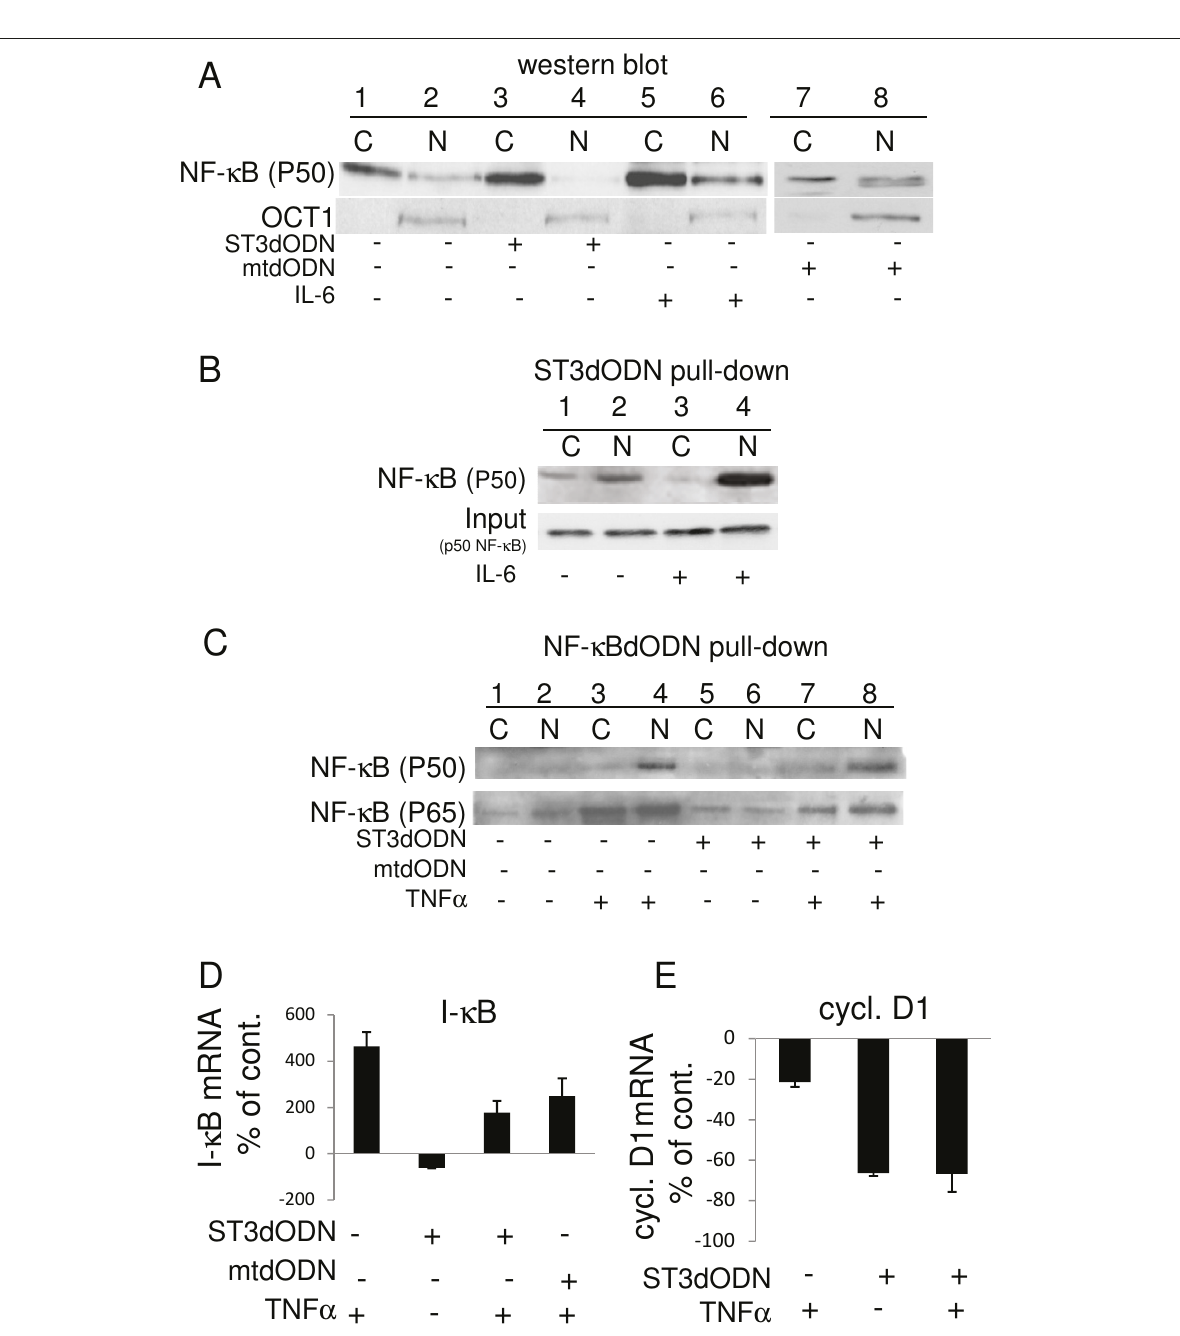
Figure 9 Functional interaction of STAT3 with NF- (cid:1) B in SW 480 cells . A : NF- (cid:1) B nuclear transfer in STAT3-decoy ODN-transfected SW 480 cells. Cells were transfected with STAT3-decoy ODN (ST3dODN) (2 μ g/ml) (3 and 4), IL-6 (50 ng/ml, 16 h) (5 and 6), or mutated STAT3-decoy ODN (mtODN) (7 and 8). Controls: 1 and 2. B : Probe of STAT3-decoy ODN pull-down with NF- (cid:1) B antibody in non-transfected cytoplasm and nuclear fractions (1 and 2) and in IL-6 (50 ng/ml)-treated cytoplasm and nuclear fractions (3 and 4). C : Analysis of NF- (cid:1) B activity by pull-down assay with NF- (cid:1) B-decoy ODN following treatment of cells with STAT3-decoy ODN (2 μ g/ml). Cells treated with TNF- a (20 ng/ml) (3 and 4) transfected with STAT3-decoy ODN (2 μ g/ml) (lanes 5 and 6), treated with both TNF- a and STAT3-decoy ODN (7 and 8), transfected with mutated STAT3-decoy ODN (2 μ g/ml) (9 and 10), or with both TNF- a and mutated STAT3-decoy ODN (11 and 12); untreated cells: 1 and 2. Western blotting with NF- (cid:1) B antibody (p50 or p65 subunits). D : mRNA levels of the NF- (cid:1) B target I- (cid:1) B (qPCR) after STAT3-decoy ODN treatment. Cells were not transfected, transfected with STAT3-decoy ODN (ST3dODN) (2 μ g/ml), treated with TNF- a (20 ng/ml), treated with both STAT3- decoy ODN and TNF- a , or transfected with mutated STAT3-decoy ODN (mtdODN) (2 μ g/ml) and TNF- a . E : mRNA levels of cyclin-D1 (qPCR) after treatment with STAT3-decoy ODN. Cells were not treated, treated with TNF- a (20 ng/ml), transfected with STAT3-decoy ODN (2 μ g/ml), or treated with both TNF- a and STAT3-decoy ODN. Results are expressed as % of